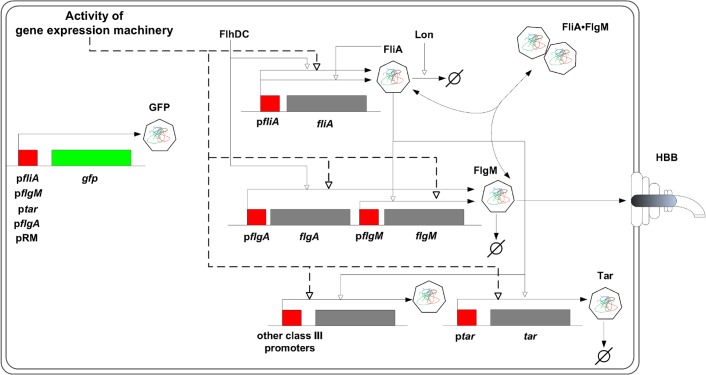
FliA-FlgM module extended with activity of the gene expression machinery.The network is the same as in Fig. 1, but the regulation of the motility genes by global physiological effects, in particular the activity of the gene expression machinery, has been included. These regulatory interactions are shown by bold, dashed lines.